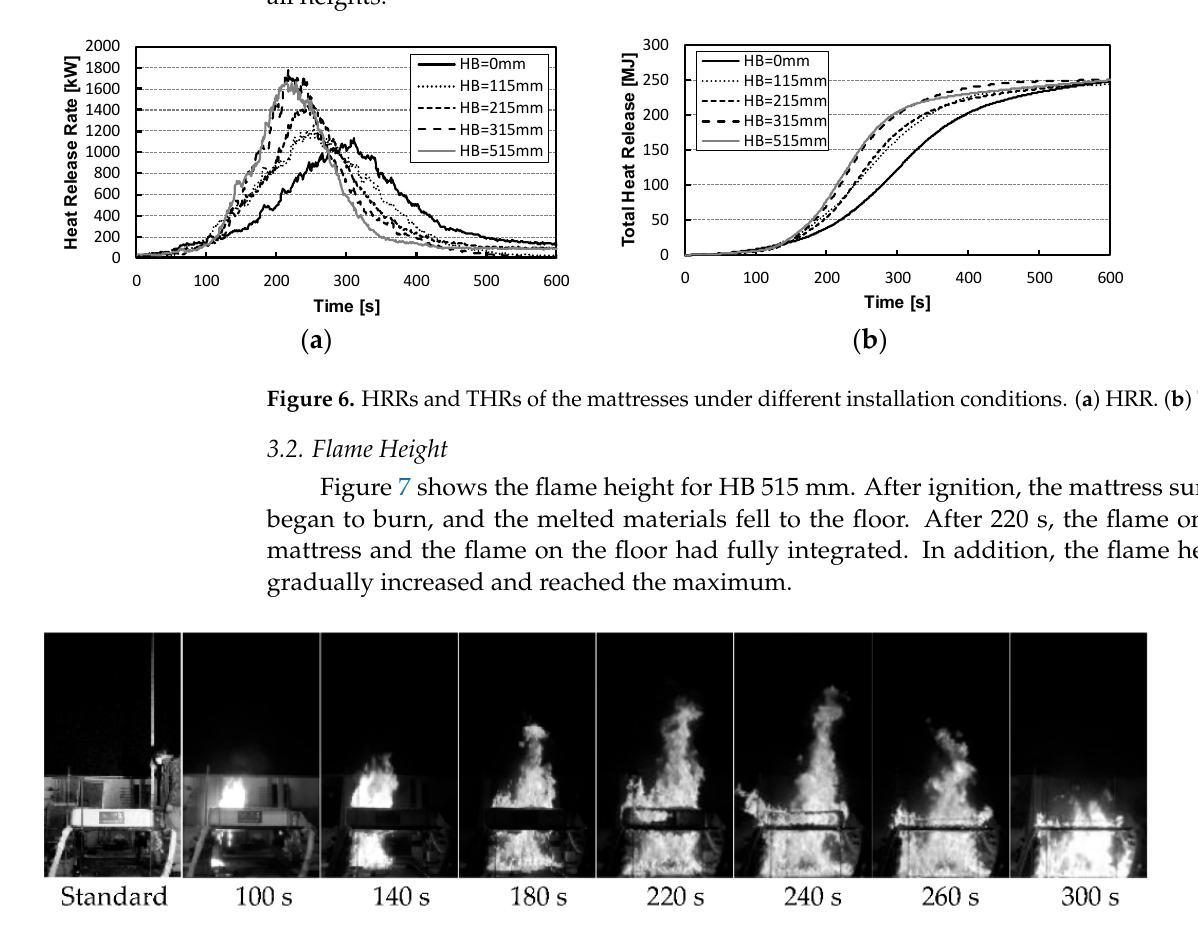
Figure 7. Flame-height images (HB 515 mm).